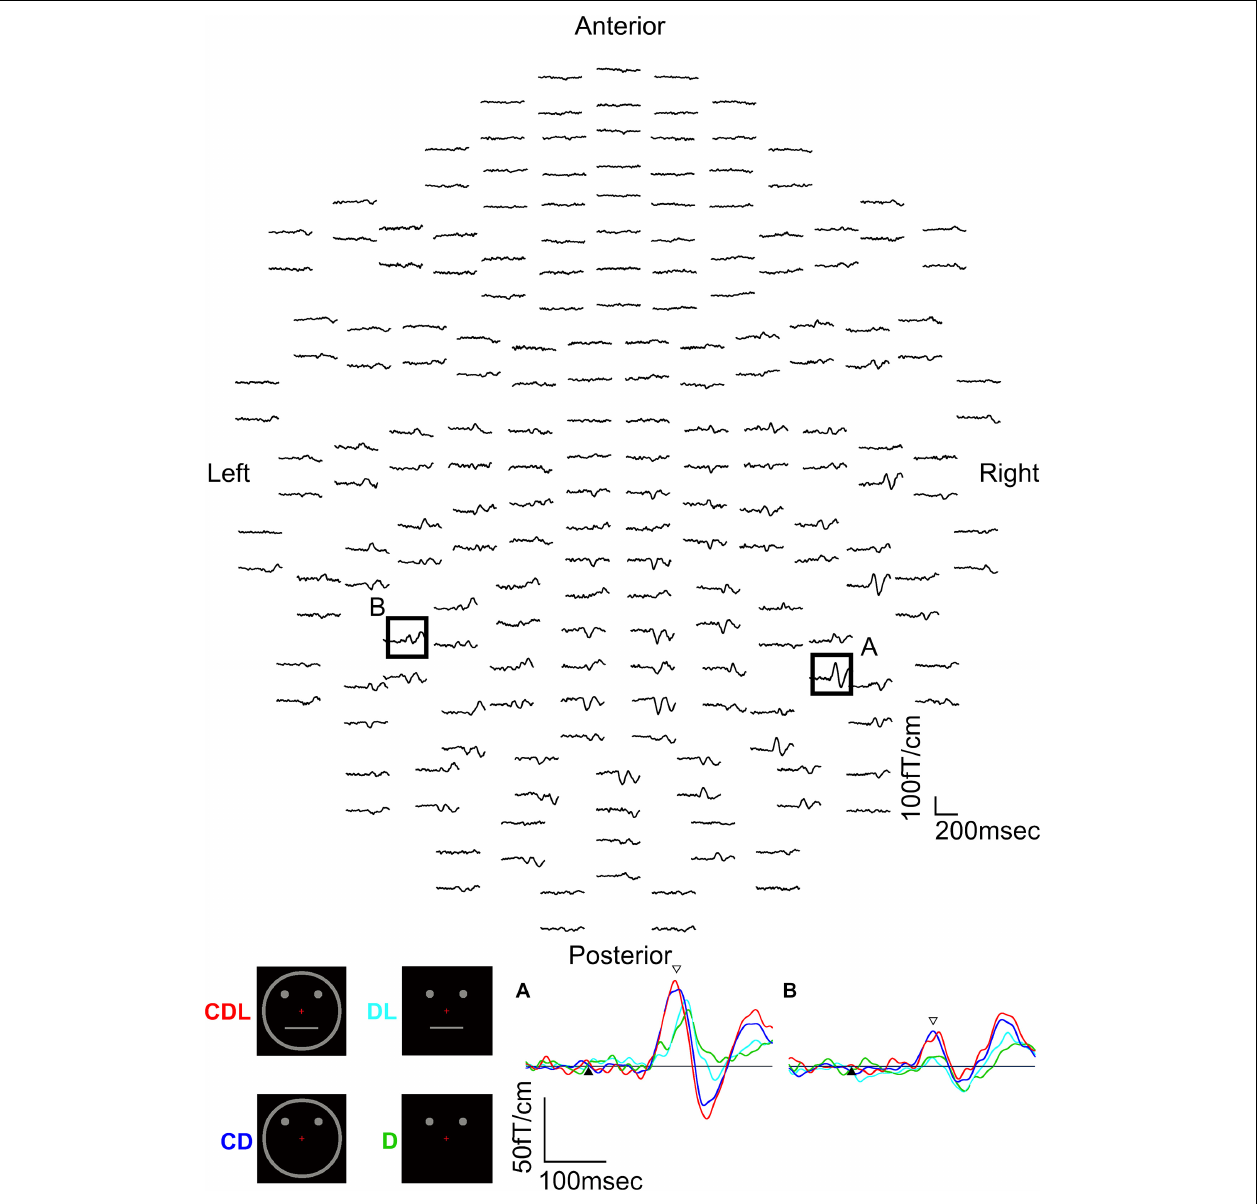
FIGURE 2 | MEG waveforms (upper) of a representative subject following the stimulus onset in the CDL condition. MEG waveforms (lower) at sensors A and B in the upper image show a clear component recorded for CDL, CD, DL, and D in the right and left hemispheres. (A) Representative waveforms at sensor A in the right hemisphere of the upper image. (B) Representative waveforms at sensor B in the left hemisphere of the upper image. Black arrows show the stimulus onset and white arrows show the response selected for further analysis [adopted from Miki et al. (2007)]. MEG, magnetoencephalography; CDL, contour, dots, and line; CD, contour and dots; DL, dots and line; D, dots